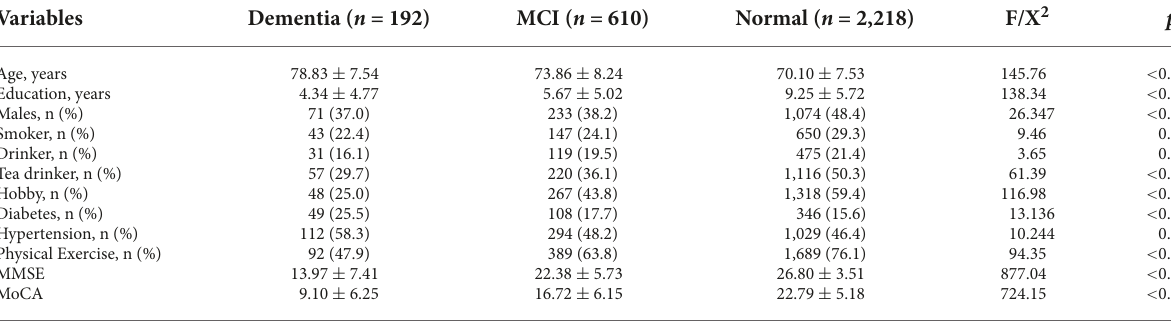
TABLE 1 Demography, lifestyle, type 2 diabetes, and cognitive function in the overall database of study participants. Variables